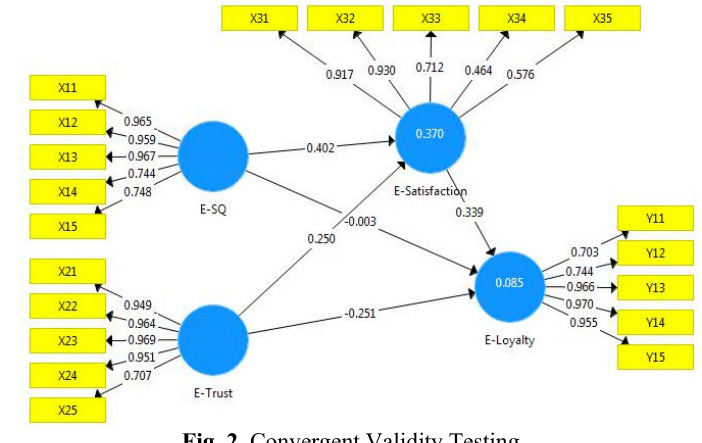
Fig. 2. Convergent Validity